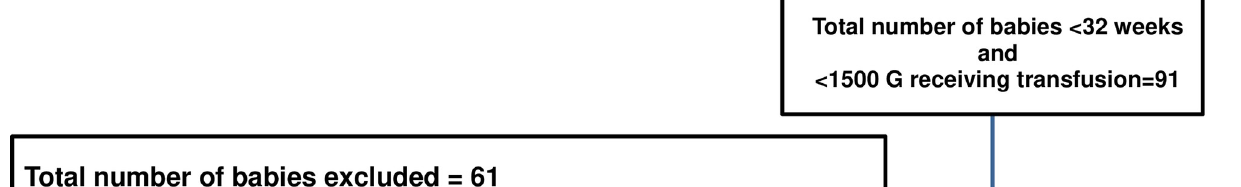
PLOS ONE | https://doi.org/10.1371/journal.pone.0271563 July 20,